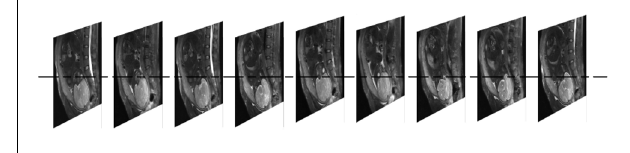
FIGURE 2 | Each patient contains 9 layers of MRI sequence